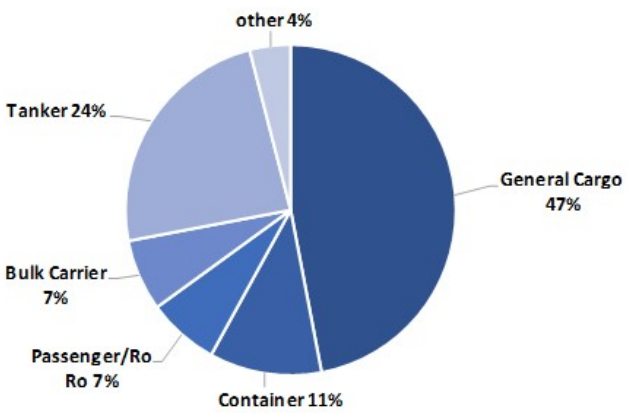
Figure 2. Ship-type breakdown in collision statistics, Project GOALDS [6]. Geometrically, collision-type damage is idealised in SOLAS as a box with two faces parallel to the waterplane, two faces parallel to the ship transversal plane, and two faces following the hull longitudinal shape at the waterline. Furthermore, the damage